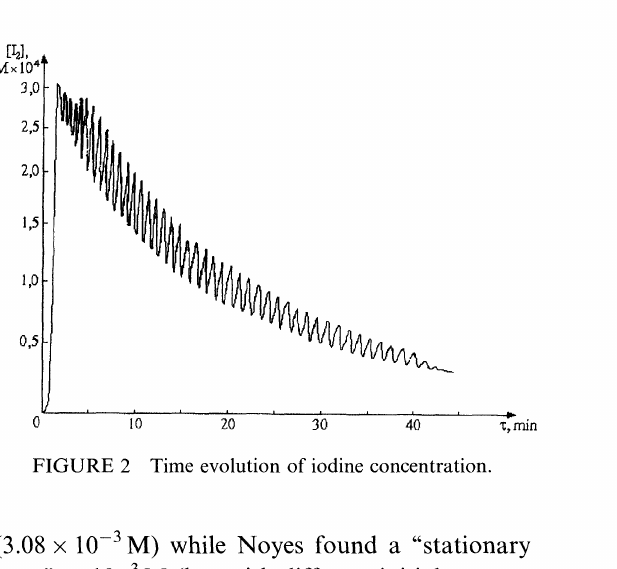
FIGURE The connections diagram of the experimental device.